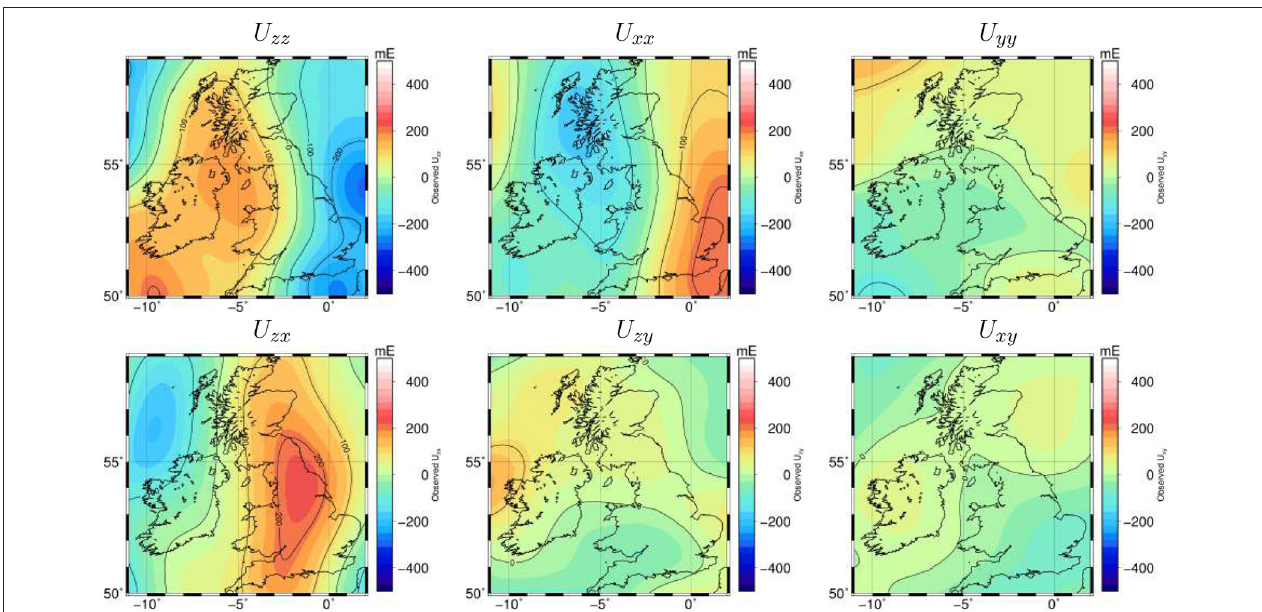
FIGURE 2 | Geophysical observables used as constraining data sets. Observed gravity gradient components derived from the global gravity model GOCO05S based on GOCE satellite data. The gradients are computed using a spherical harmonic synthesis code from degree 10 up to 220 (see appendix in Fullea et al. (2015) and Martinec and Fullea (2015)). x-direction corresponds to E, y-direction to N and z-direction to vertical. Isolines every 100